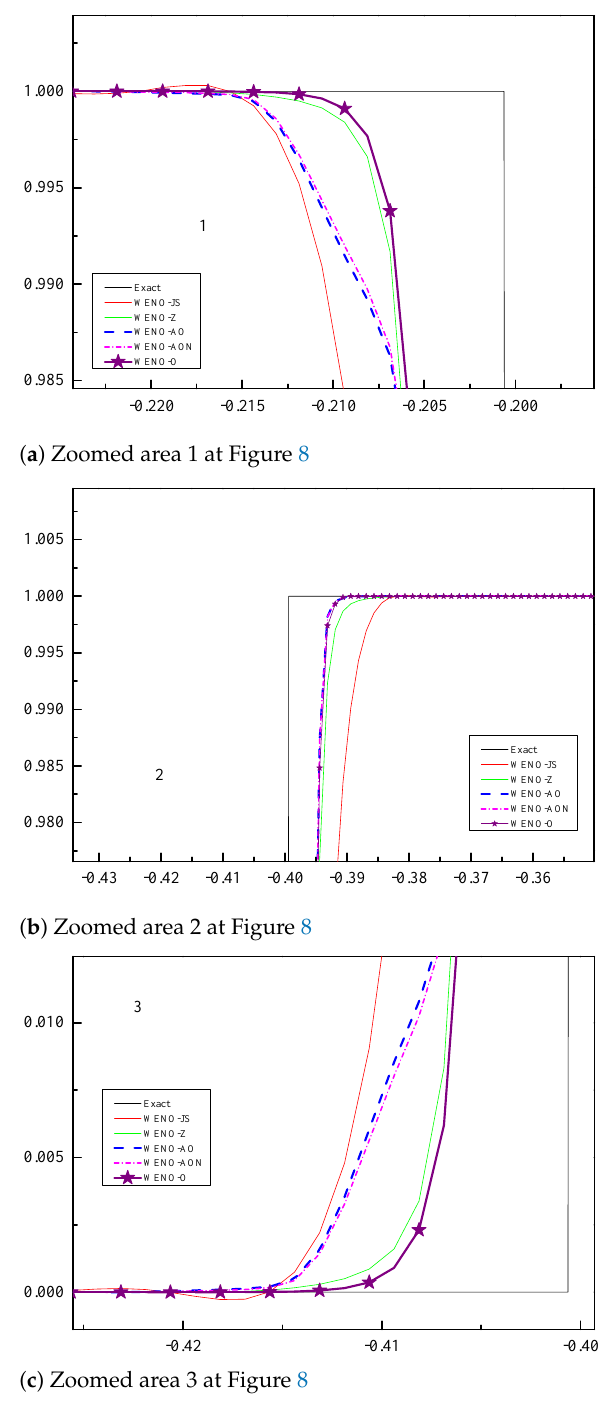
( c ) Zoomed area 3 at Figure 8 Figure 9. Cont